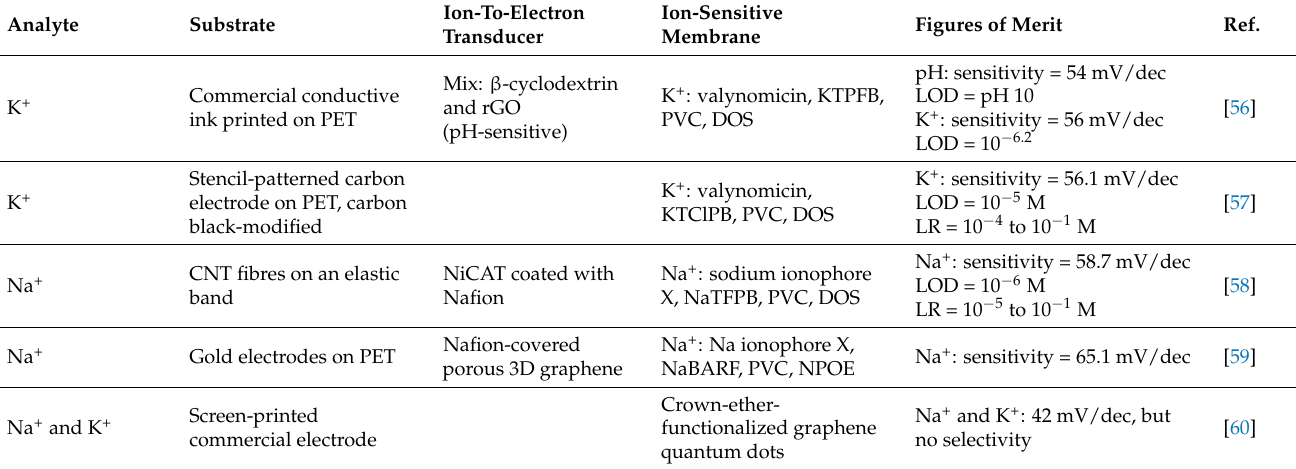
Summary of the ISEs proposed in the recent